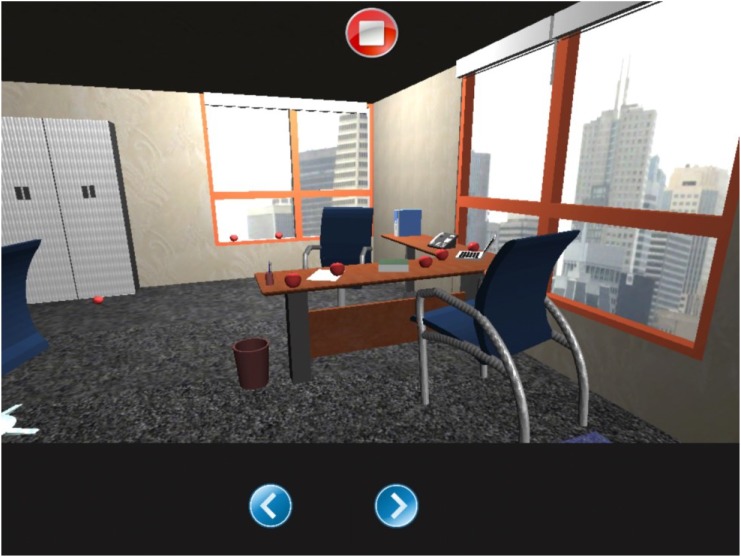
Apples pursuit task.